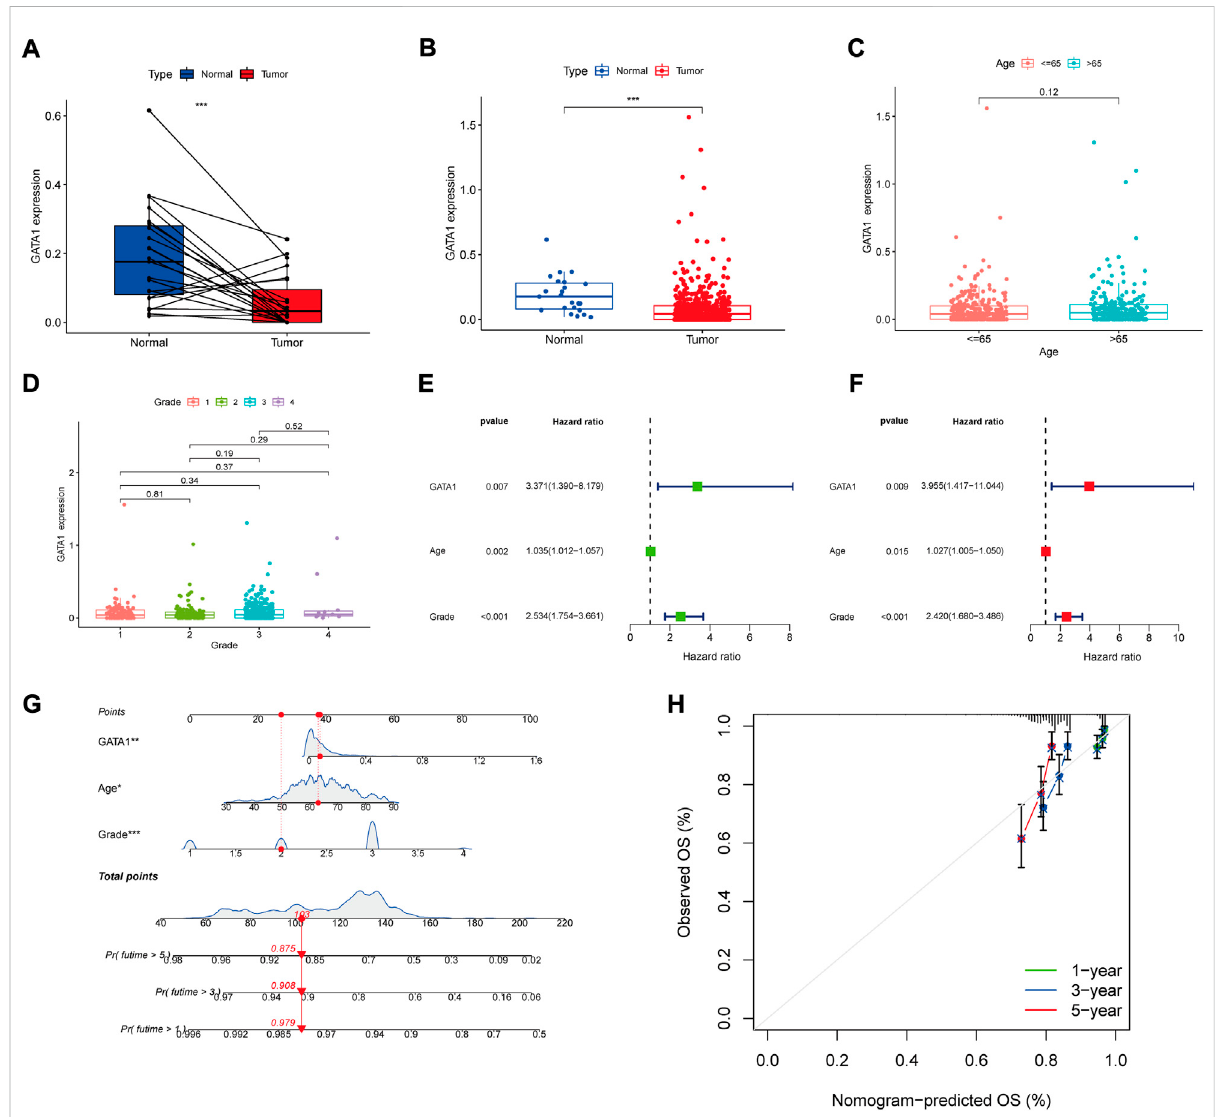
FIGURE 4 GATA1 clinical correlation and independent prognostic analysis. (A) GATA1 expression in patients in the tumor group and in tumor and normal tissues; (B) GATA1 expression inpatients in thenormaland tumor groups; (C) GATA1 expression insamples from patients indifferent age groups; (D) GATA1 expressioninsamplesfrom patients atdifferentstages; (E,F) Univariate and multivariate Cox regression independentprognostic analyses; (G) Nomogram predicting 1-, 3- and 5-years survival rates in UCEC patients; (H) Columnar plot calibration curves for testing deviations between predicted and actual 1-, 3- and 5-years survival probabilities in